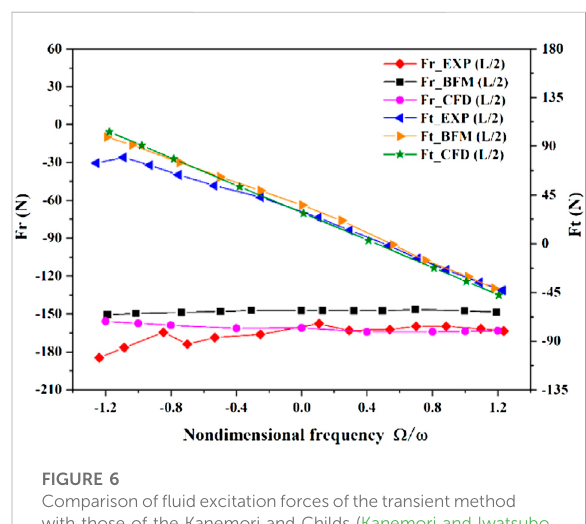
FIGURE 6 Comparison of fl uidexcitationforcesofthetransientmethod with those of the Kanemori and Childs (Kanemori and Iwatsubo,